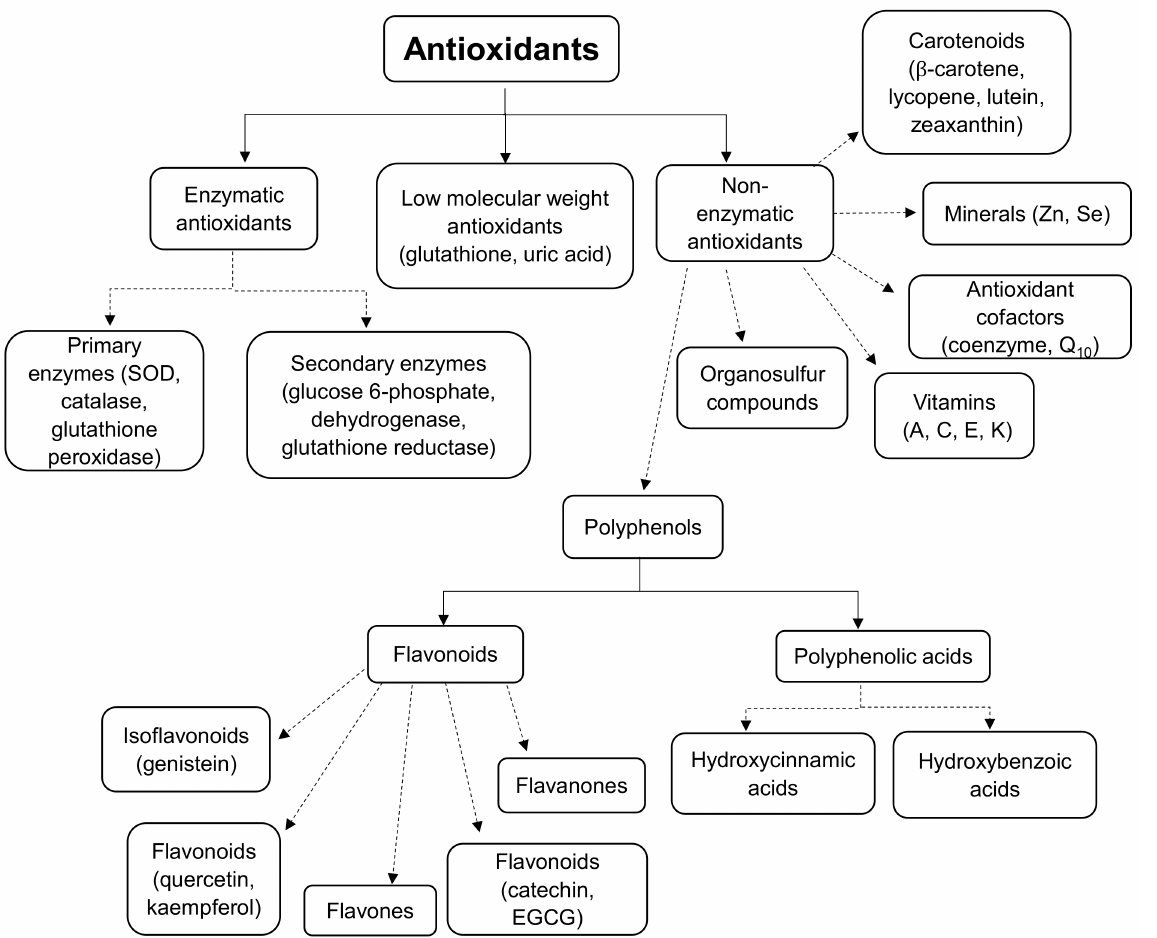
Figure 2. Classifications of